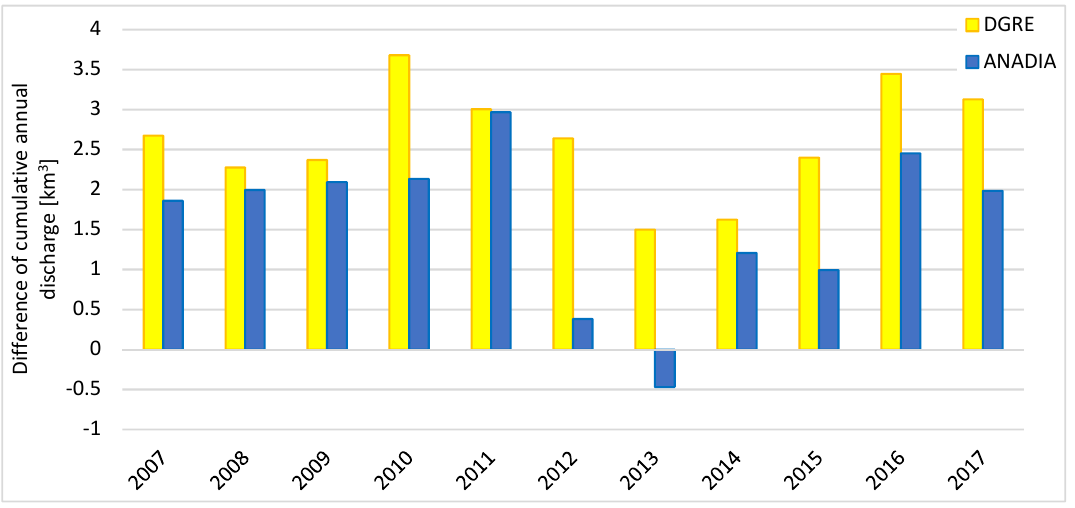
Figure 4. Water balance (2007–2017) at Niamey computed with DGRE (yellow bars) and with ANADIA (blue bars) discharge time series.